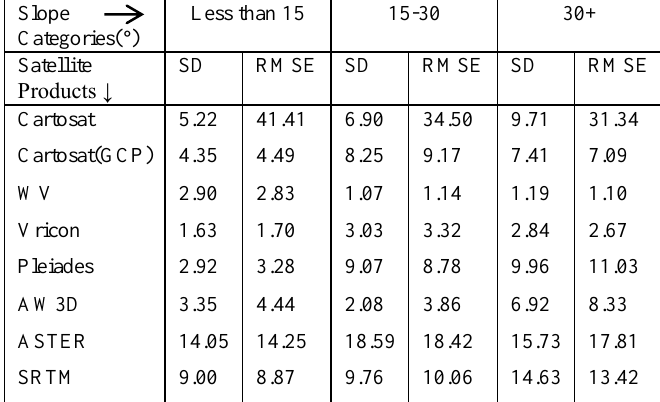
Table-5: Vertical error statistics in different slope